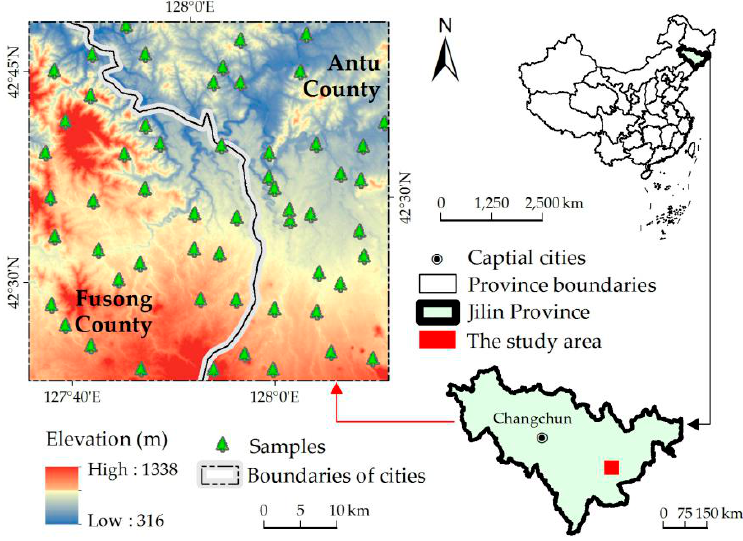
Figure 1. The location of the study area and surveyed forest quadrats.